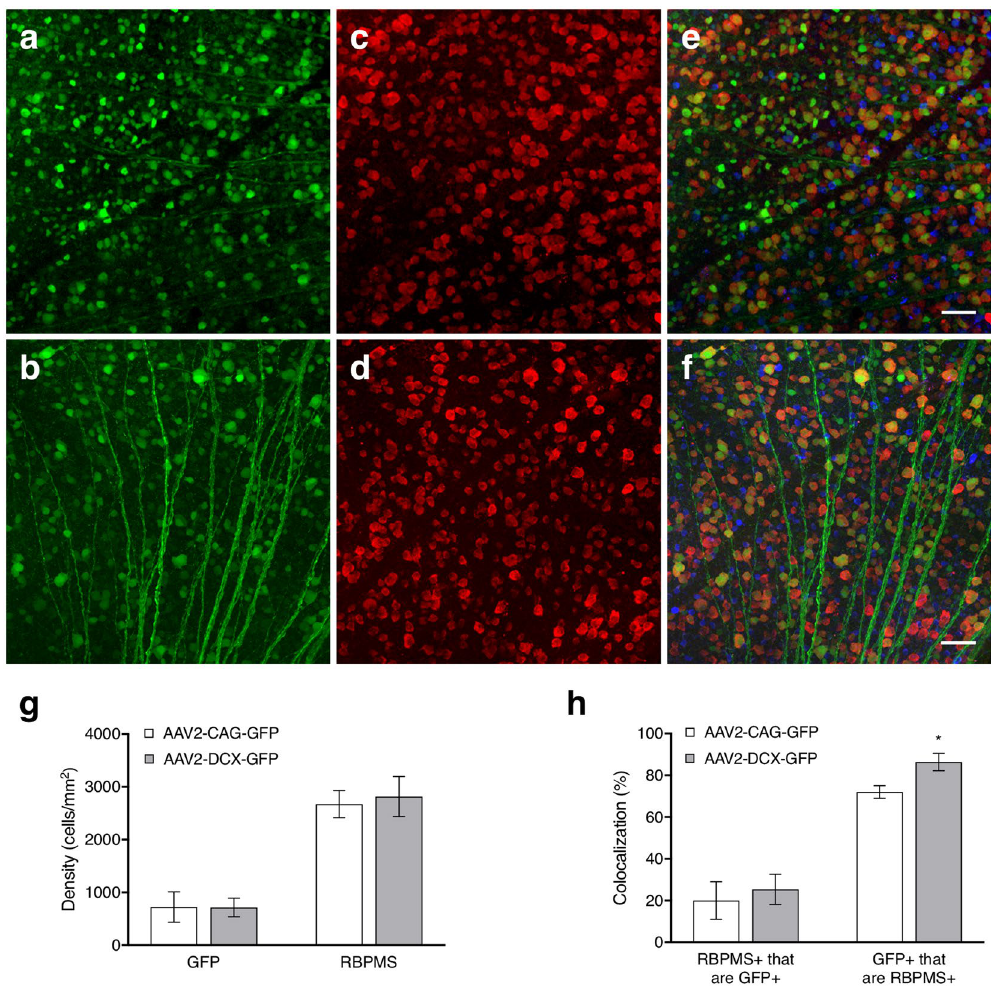
Figure 3. Cellular labelling in flat-mount retinas with the two AAV2 vectors. Panels (a,c and e) are micrographs from an animal that received an injection of the AAV2-CAG-GFP vector while panels (b,d and f) are from an animal that received an injection of the AAV2-DCX-GFP vector. ( a , b ) Show GFP labelling via intravitreal injection of AAV2-GFP vector ( green ); ( c , d ) immunohistochemical labelling of RGCs with RNA binding protein with multiple splicing (RBPMS, red ) and ( e , f ) respective merged images with choline acetyltranferase (ChAT, blue ). Scale bars = 50 μ m. ( g ) Density of GFP positive cells from an AAV intravitreal injection and RBPMS positive cells from immunohistochemical labelling. ( h ) RBPMS + cells that are GFP + indicates the proportion of RGCs labelled by GFP and GFP + cells that are RBPMS + indicates the specificity of the AAV vector to RGCs. Histograms show means and error bars show 95% confidence intervals; * p < 0.05; n =